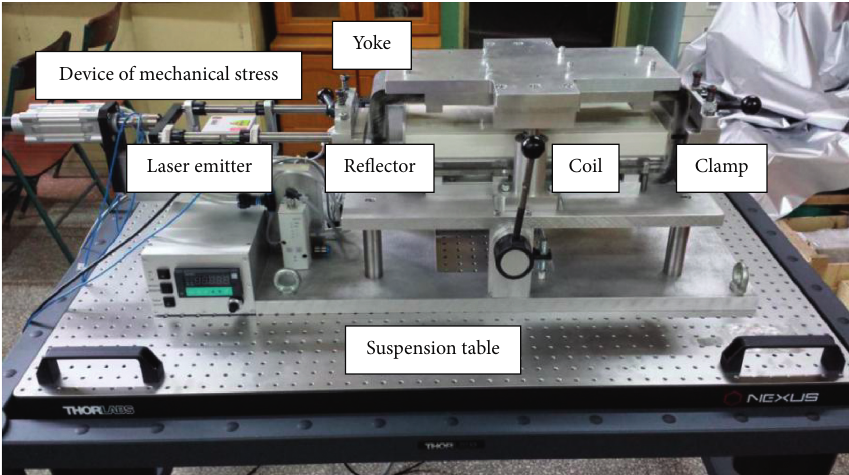
Figure 1: Photo of the magnetostriction coefficient measuring instrument.